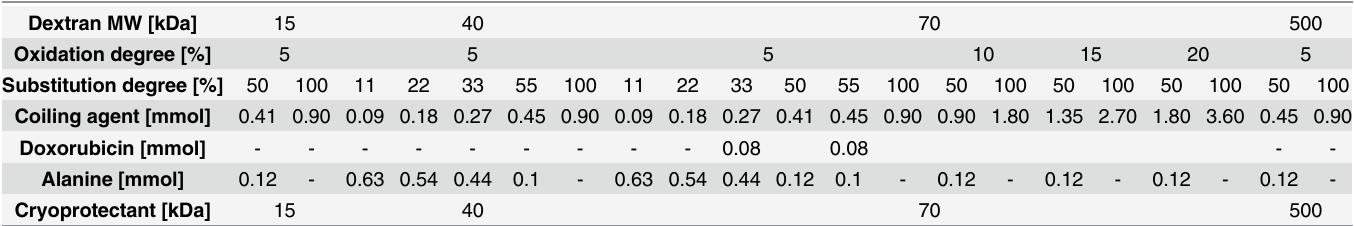
Table 2. Amount of substances in NP synthesis for 1 g dextran.